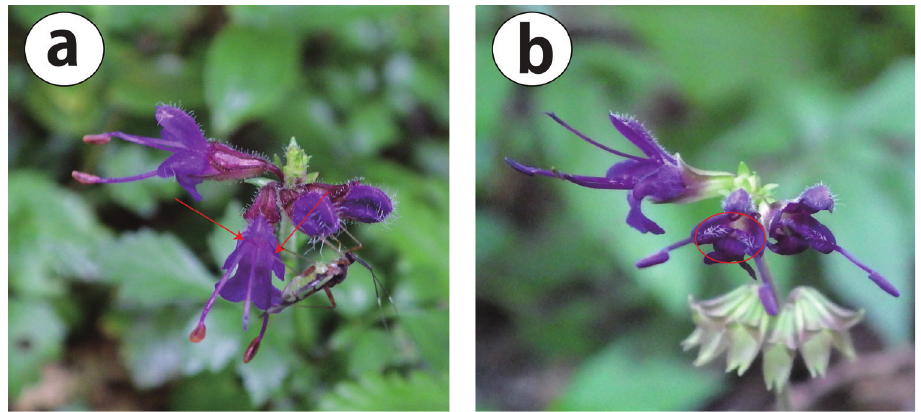
Figure 2. Photographs of S. lutescens var. intermedia flowers. a Flower of A. Takano 140806-4-2 (HYO), from Mt. Mikuni, Susono-shi, Shizuoka Pref. (Kanto region). Arrows indicate the base of the anther connec- tive. No hairs are visible b Flower of A. Takano 140813-1 (HYO), from Mt. Yamatokatsuragi, Gose-shi, Nara Pref. (Kinki region). The red open circle indicates the base of the anther connective. White hairs are